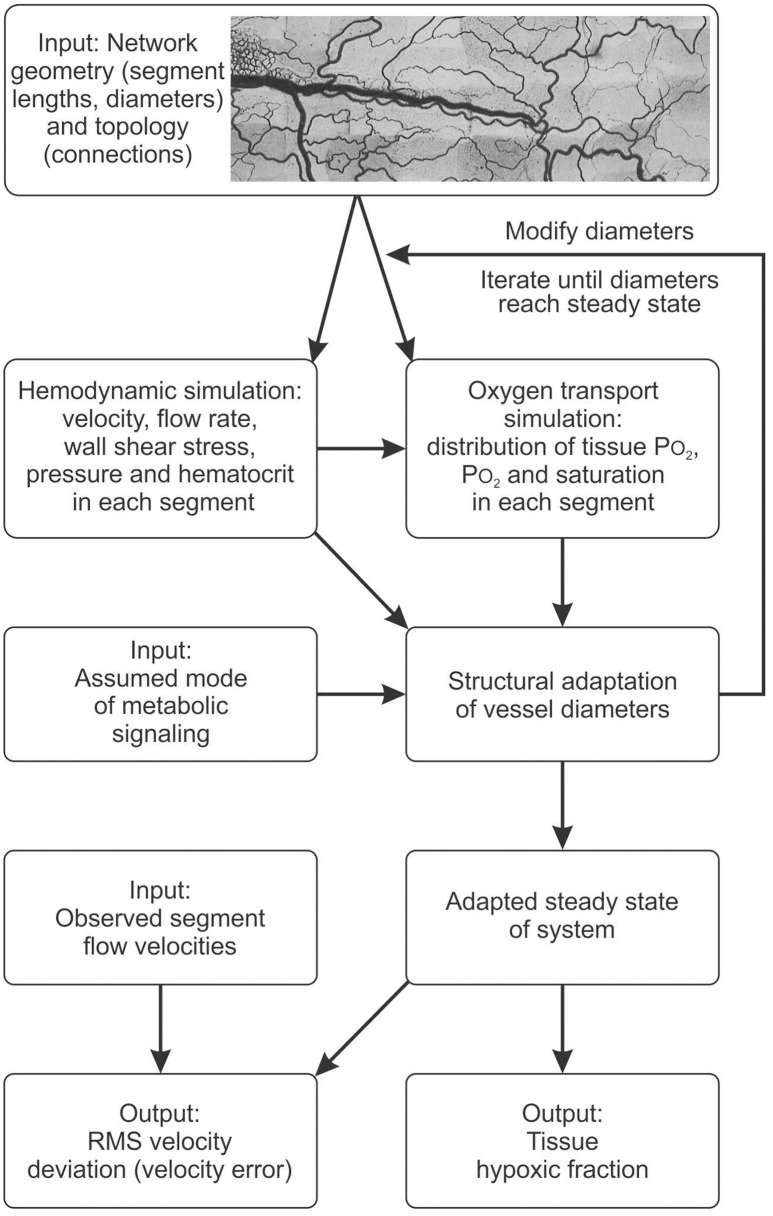
Schematic outline of modeling approach, indicating data input and assumptions used as input to the model, major steps in the computation, and resulting outputs. See text and supplement for details.